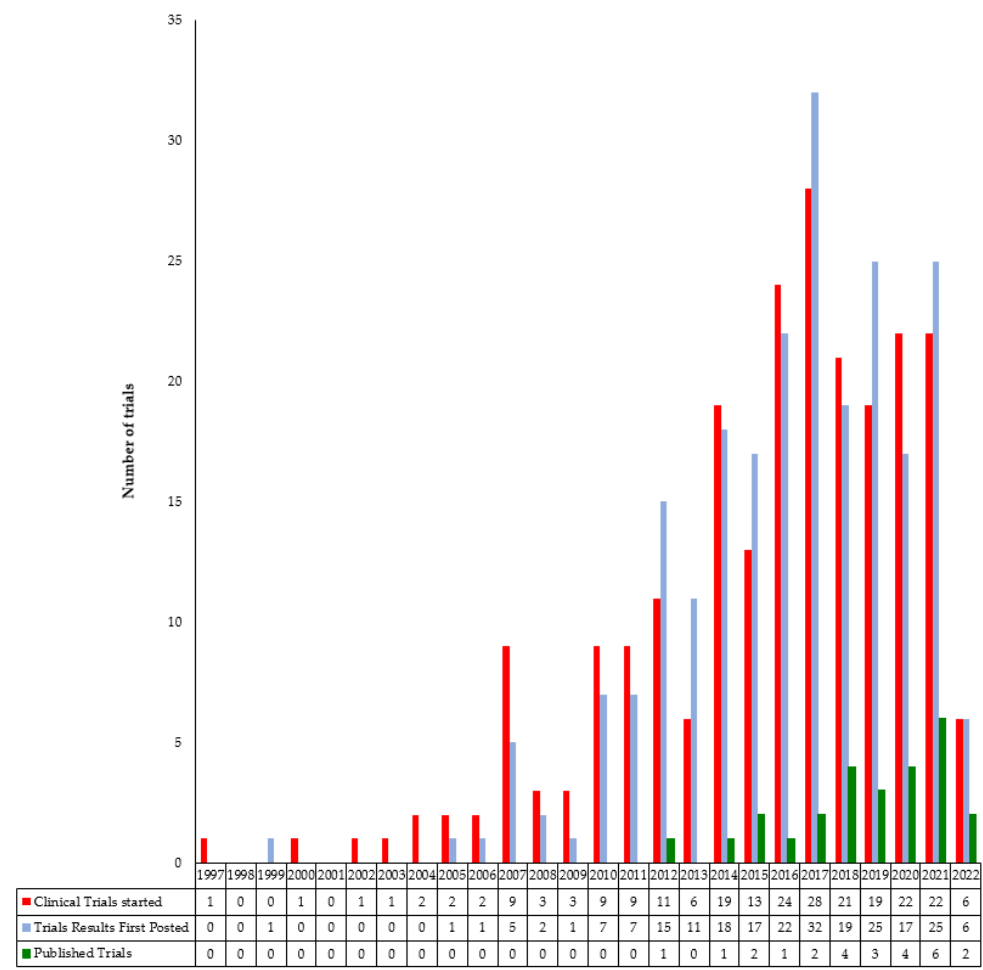
Figure 2. Cumulative number of clinical trials that started per year, that reported results to ClinicalTrials.gov, or that were published.